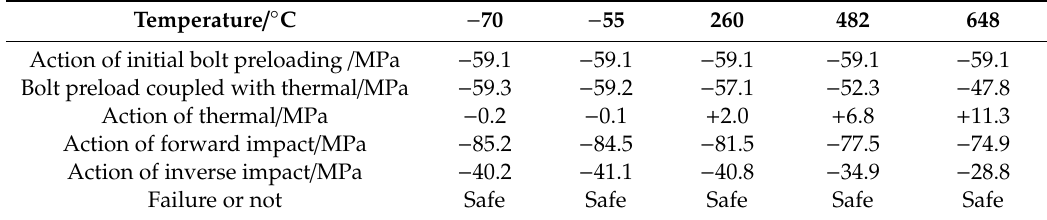
optimized design.